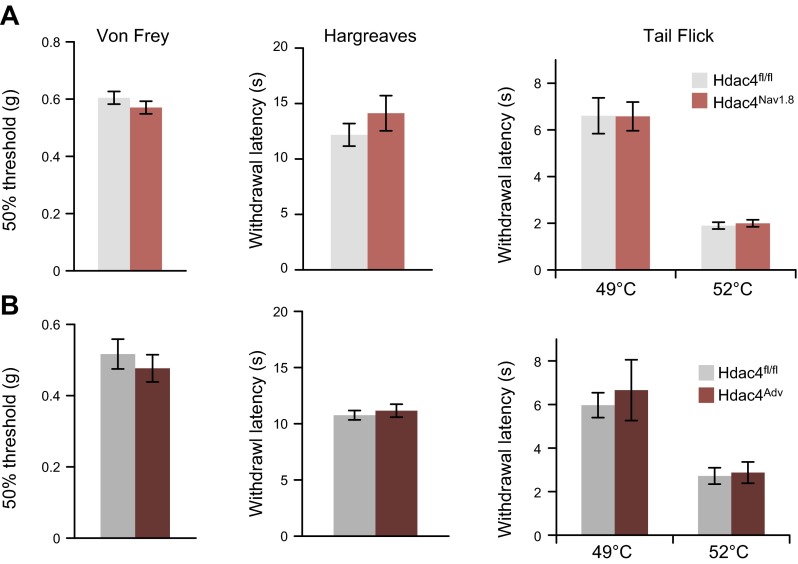
Loss of HDAC4 does not affect baseline somatosensation. Mechanical sensitivity was measured by the Von Frey test; thermal sensitivity was assessed by the Hargreaves and the tail-flick tests. No significant differences were seen between groups across any of these measures for (A) HDAC4Nav1.8 or (B) HDAC4Adv (n = 7–30). Nonsignificant, Student’s t test.